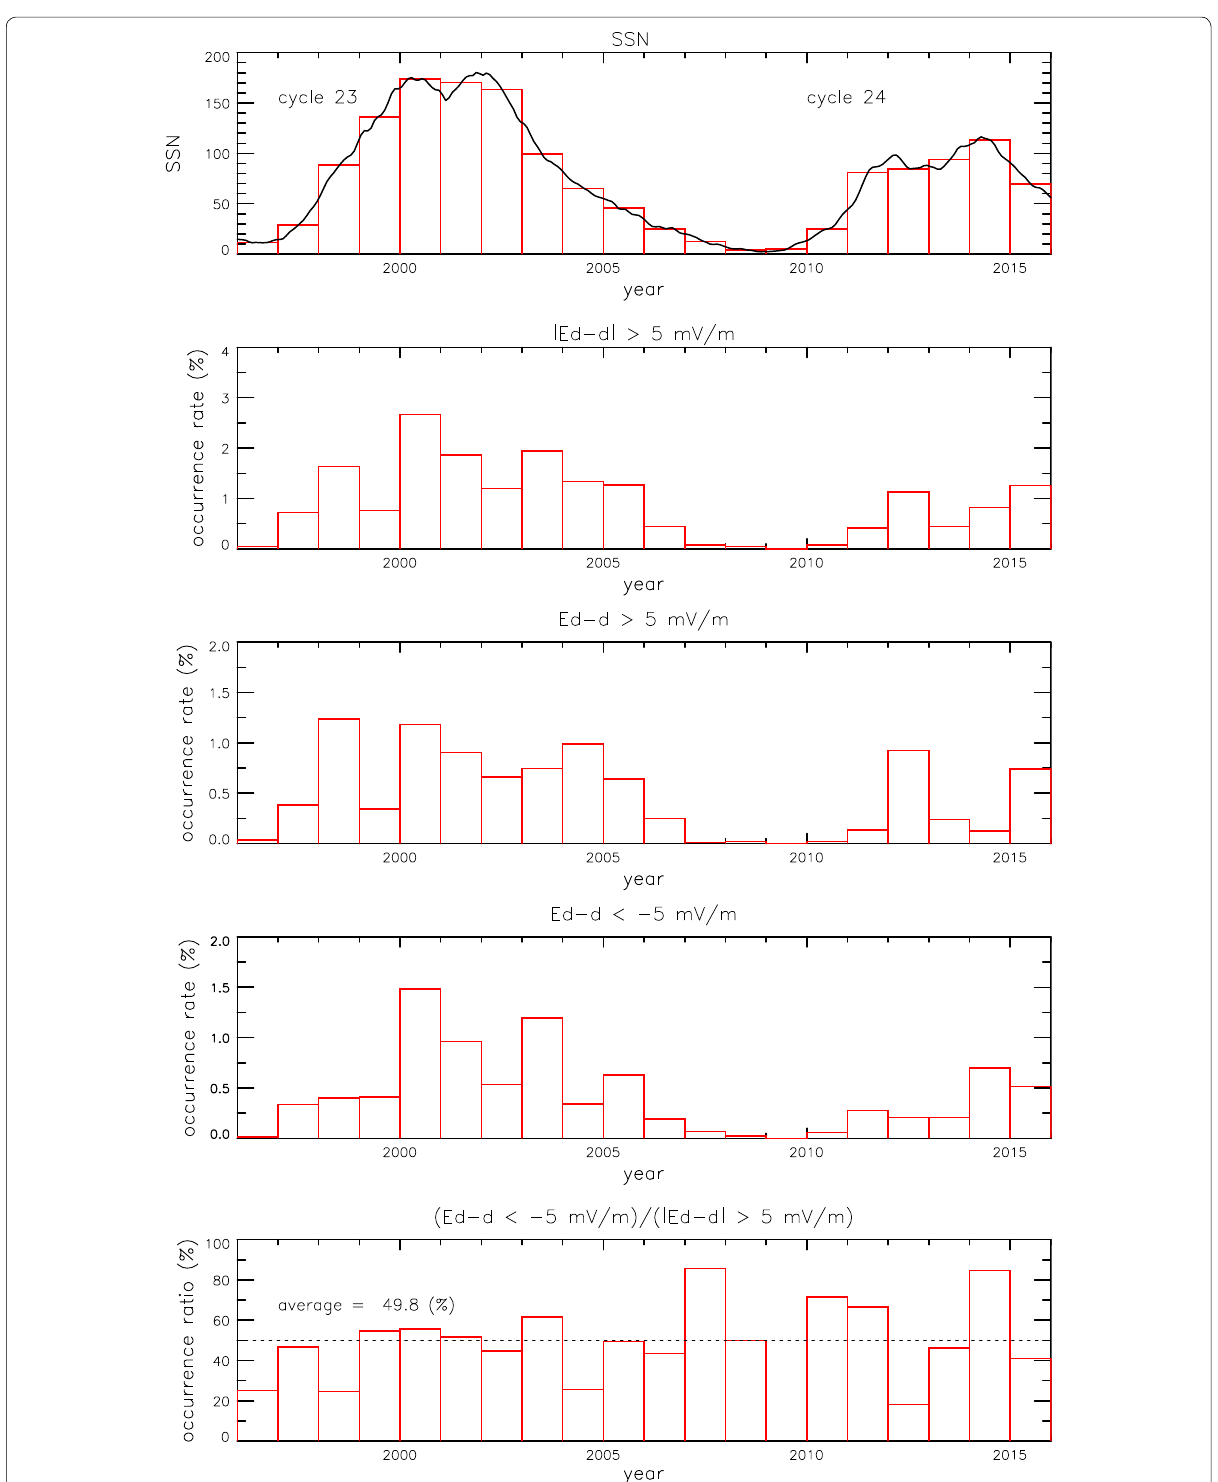
Fig. 4 Top panel is the yearly SSNs ( red line ) with the 13-month smoothed monthly SSNs ( black line ). The second , third , and forth panels are the yearly occurrence rates of | E d–d | > 5 mV/m, of E d–d > 5 mV/m, and of E d–d < E d–d < 5 mV/m to | E d–d | > 5 −